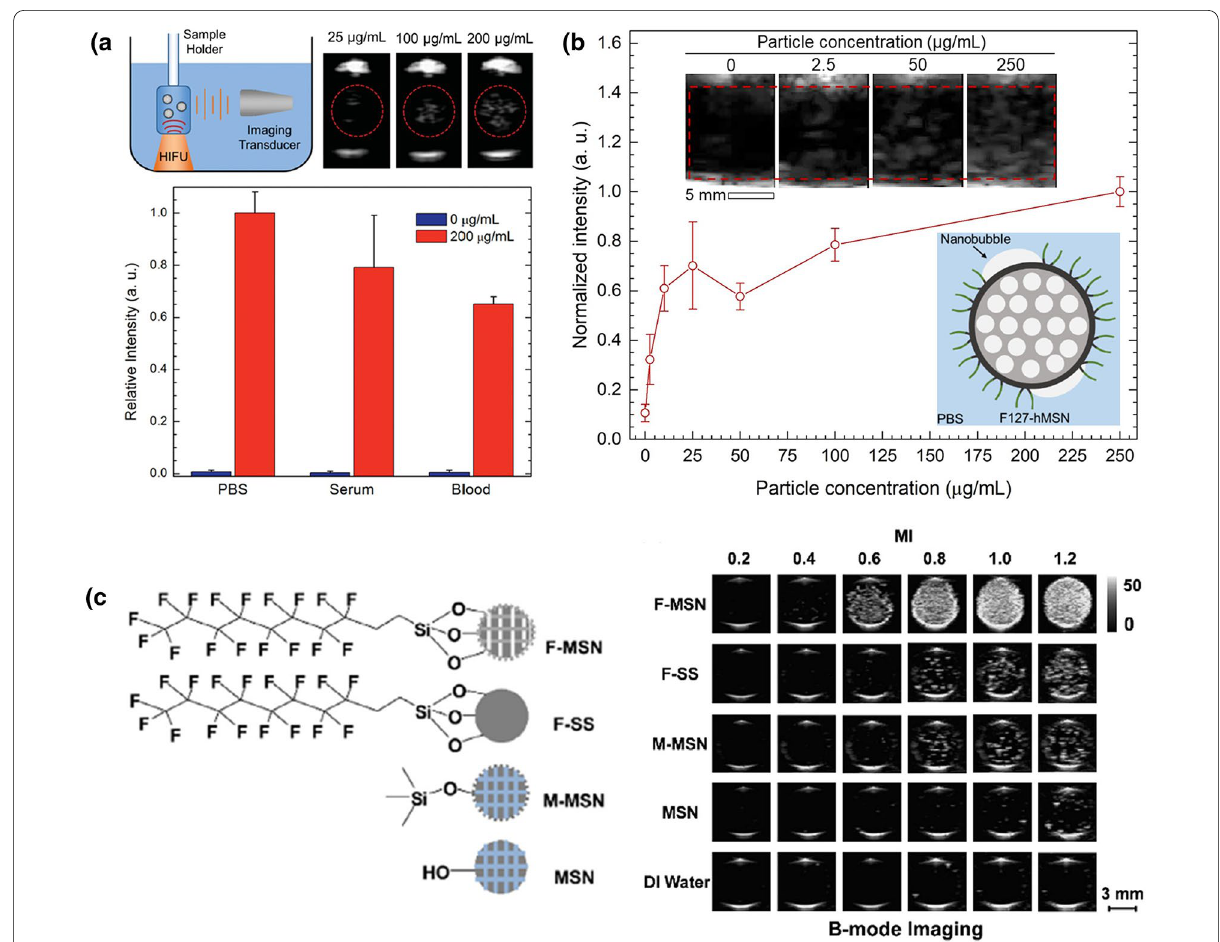
Fig. 6 Ultrasound contrast generation by different MSN based GSNs. a Ultrasound contrast enhancement by F127 coated hydrophobic MSNs under HIIFU insonation in different media. Adapted from reference [34], Copyright 2016, John Wiley and Sons. b Average ultrasound intensity generated by F127 coated hydrophobic MSNs at different particle concentrations during ultrasound imaging at 2.5 MHz, and MI from reference [39], https:// pubs. acs. org/ doi/ 10. 1021/ acsom ega. 0c033 77, 2020, further permissions related to the material excerpted should be directed to the American Chemical Society. c Ultrasound images of differently modified MSNs or solid silica nanoparticles at different MI values under B-mode imaging. Adapted from reference [36], Copyright 2017,